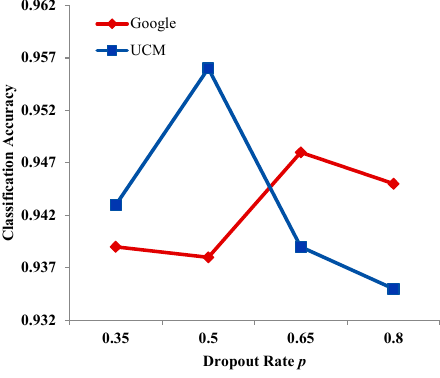
Figure 12. The relationship between dropout rate and classification accuracy.